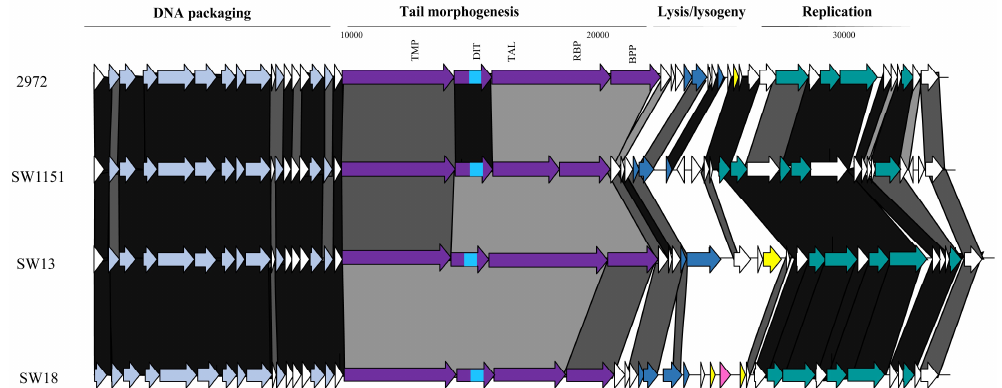
Figure 4. Genomic comparisons of representative pac phages from this study and the reference pac phage, 2972. The functions of the gene modules are indicated above the diagram and correspond to the colour-coded arrows as follows: pale blue arrows represent genes encoding DNA packaging and capsid morphogenesis functions; purple arrows indicate tail adhesion/injection device components including the TMP, Dit, Tal–RBP, and baseplate proteins (BPP); pink arrows indicate the presence of lipoprotein-encoding genes; yellow arrows represent repressor/anti-repressor encoding genes; and teal green coloured arrows represent genes encoding predicted DNA replication functions. The bright blue area within the arrow representing the Dit-encoding genes represents the region that encodes a carbohydrate binding domain. Where arrows are joined by a black shaded area, the represented gene products are between 90% and 100% similar at the aa level; dark grey indicates 70–89% similarity and light grey indicates 50–69% aa identity between the gene products. Unshaded regions represent those possessing less than 50% aa